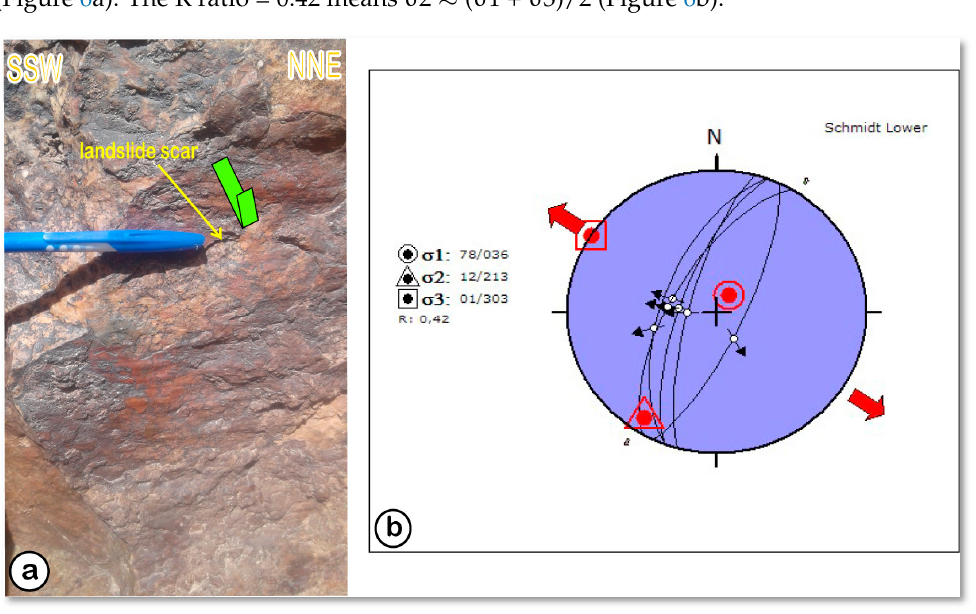
Figure 6. ( a ) Field photograph showing a NNE-SSW normal faults; ( b ) stereographic projection of the fault analysis and the interpreted stress axis during the during synsedimentary and syn-volcanism early Ediacaran extension.